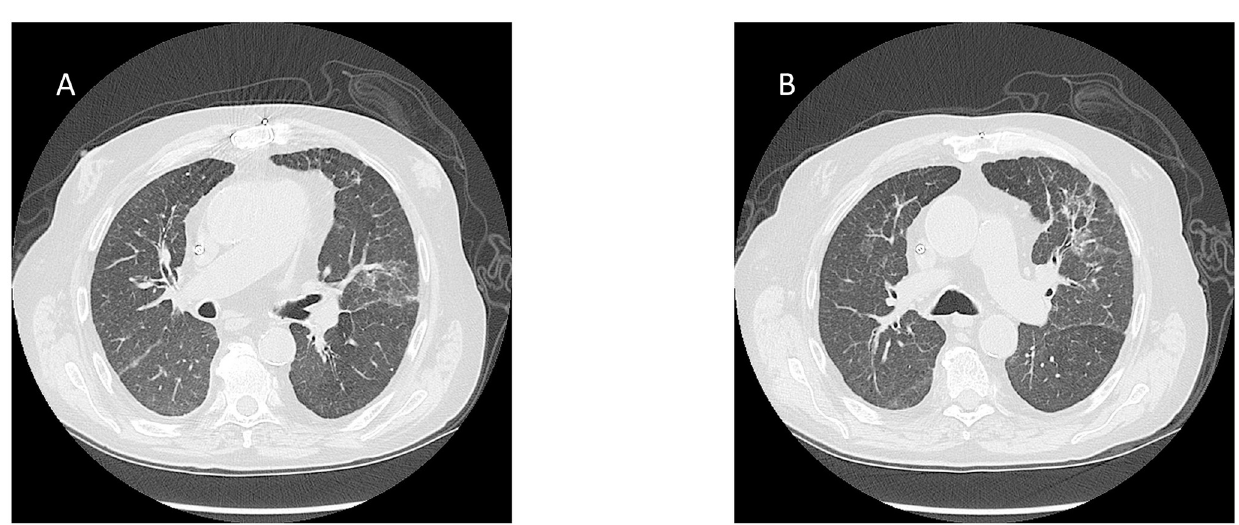
Fig 4. Computed tomography (CT) of two patients infected with SARS-CoV-2 with (Group 1, SC-2D) (A) and without (Group 2, SC-2) (B) dyspnea. In both images, interlobular septal thickening and patchy ground-glass opacities are evident.